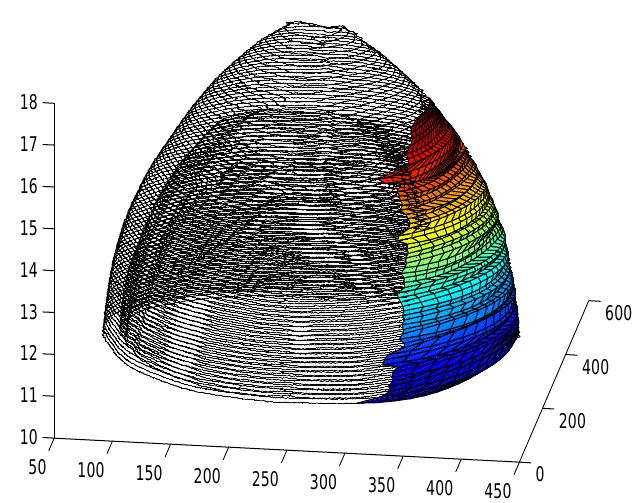
Figure 19. Reconstructed 3D craniofacial fracture of parietal bone